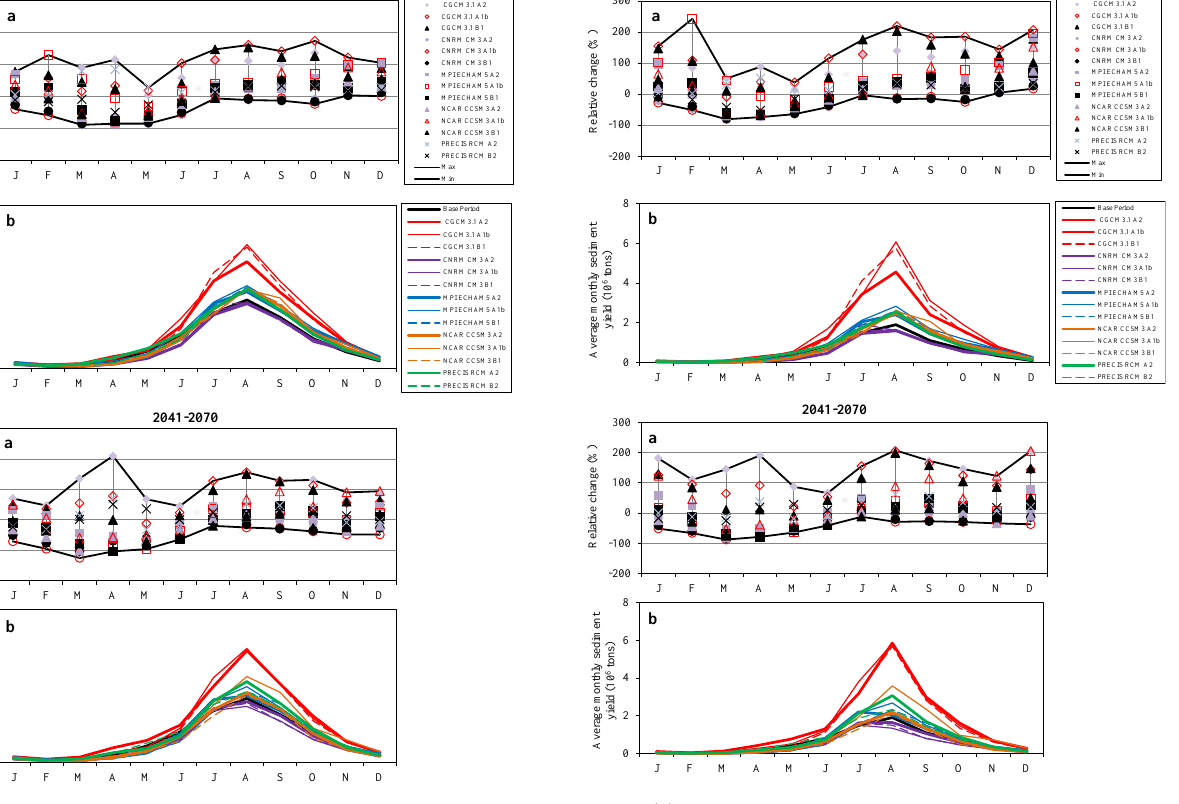
Fig. 12. (a) Change in future monthly streamflow for all climate projections relative to 1971–2000 and (b) annual discharge cycle for present (1971–2000) and for all climate projections. Results are for the 2011–2040 and 2041–2070 time periods.